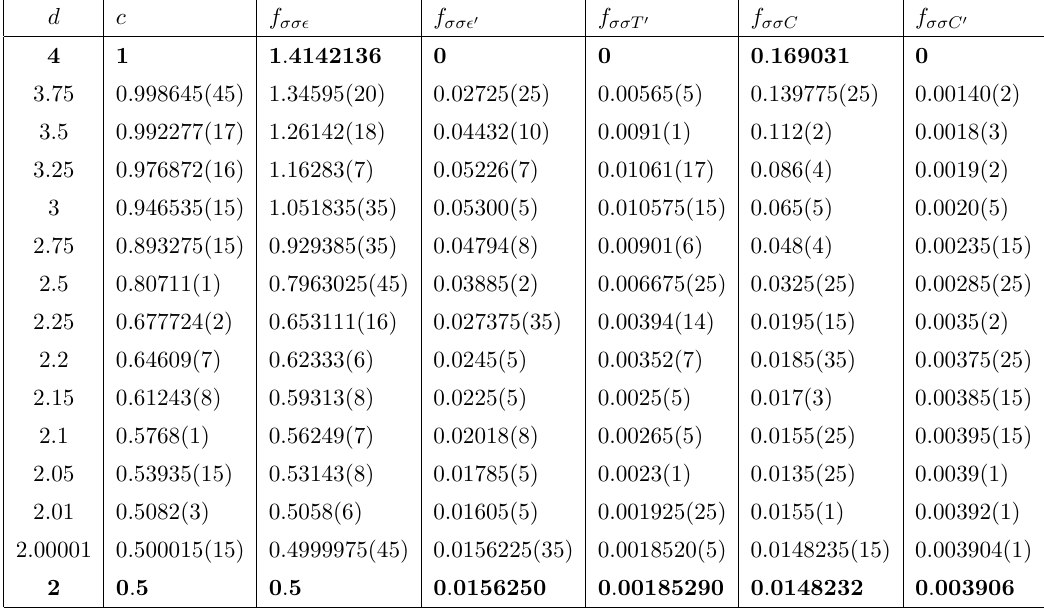
Table 5 . Structure constants of six low-lying states for 4 > d > 2. The exact values for d = 2 ;